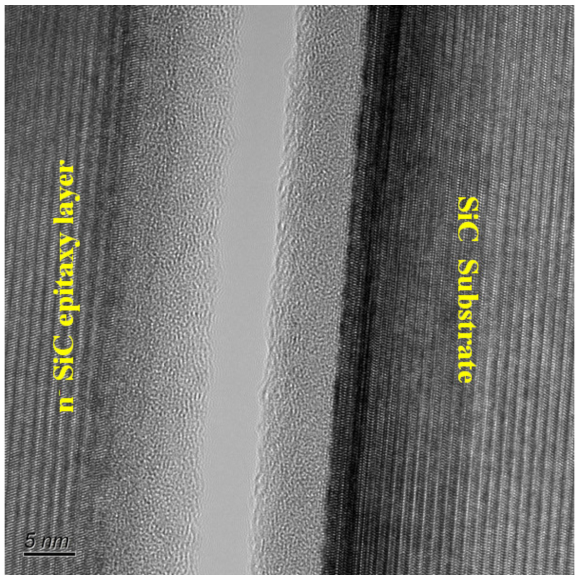
Figure 9. TEM image of the bonding interface of SiC wafer to n − SiC epitaxy growth